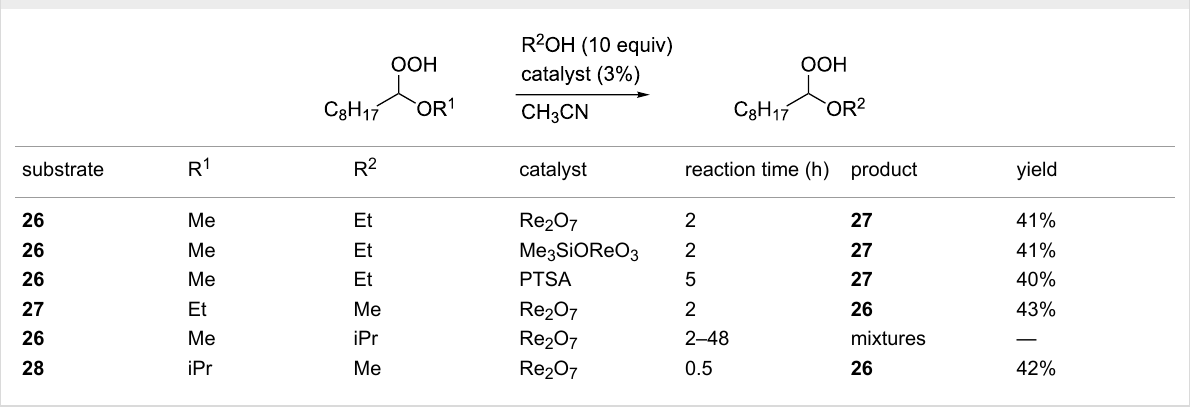
Table 8: Alkoxide exchange within hydroperoxyacetals.